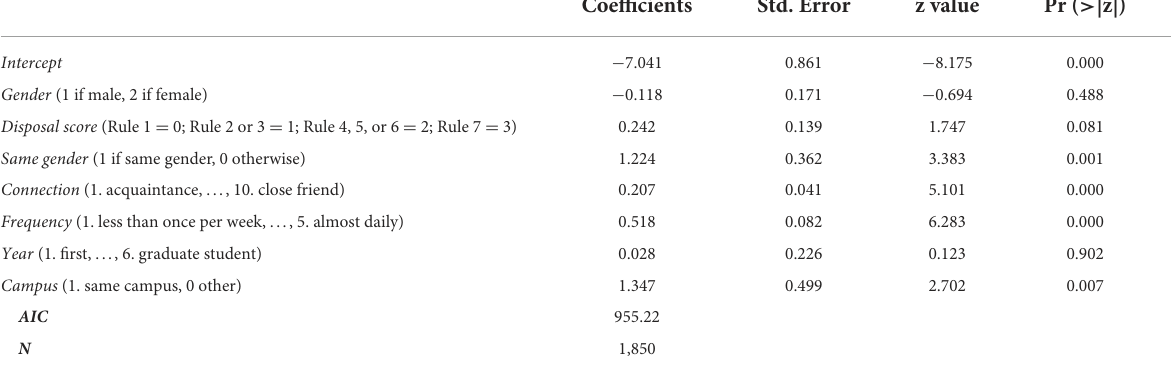
TABLE 6 Logistic model explaining factors associated with spreading